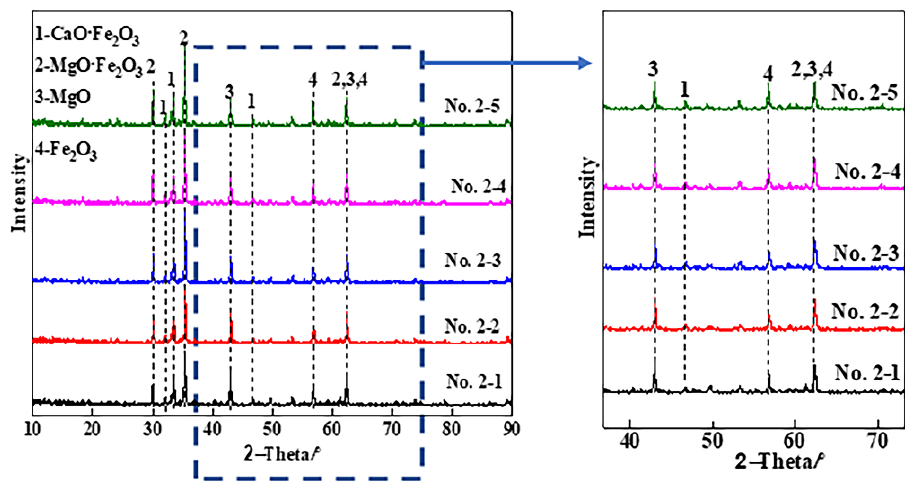
Figure 12. The XRD analysis of Fe 2 O 3 -MgO-CaO.